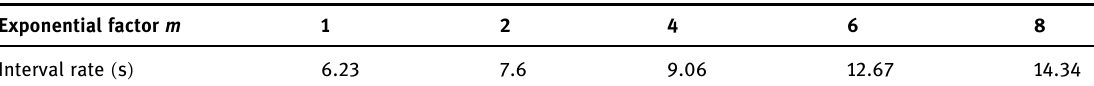
Table 9: Detection e ffi ciency of normal fi les Exponential factor m